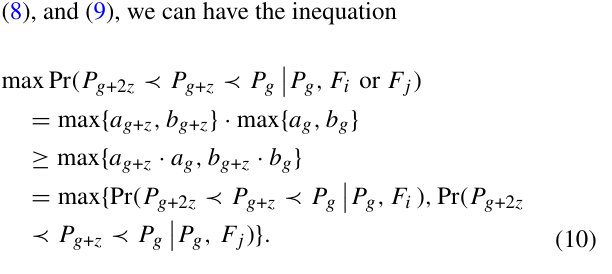
Fig. 1 The overall framework of MO-MCEA